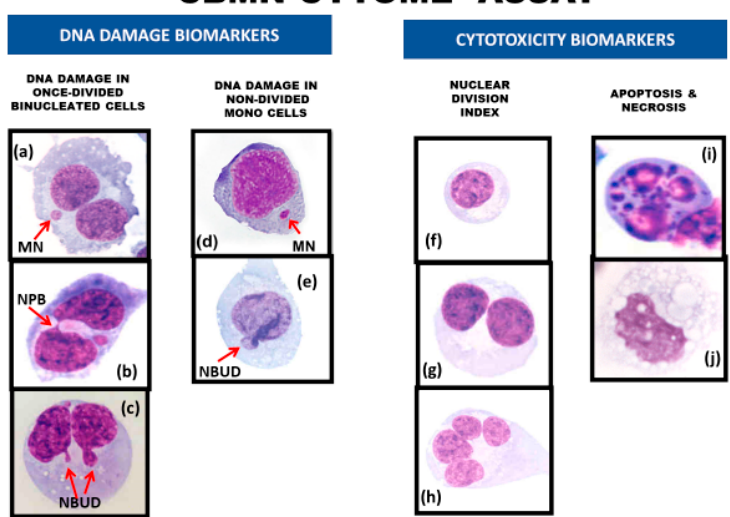
Figure 4. DNA damage and cytotoxicity biomarkers in the lymphocyte cytokinesis-block micronucleus cytome (CBMN-Cyt) assay. DNA damage biomarkers include ( a ) binucleated (BN) cells with a micronucleus (MN), ( b ) BN cells with a nucleoplasmic bridge (NPB), ( c ) BN cells with a nuclear bud (NBUD), ( d ) mononucleated (MONO) cells with a MN, and ( e ) MONO cells with a NBUD. Cytotoxicity biomarkers include the relative frequencies of ( f ) MONO cells, ( g ) BN cells, and ( h ) multi-nucleated cells with three or more nuclei, which together are used to measure the nuclear division index, a measure of cytostatic effects. In addition, ( i ) apoptotic cells and ( j ) necrotic cells are scored to obtain a measure of total cell death and the type of cell death. This figure has been adapted from Figure 1 in Rodrigues et al. [38]. Permission was obtained from the publisher